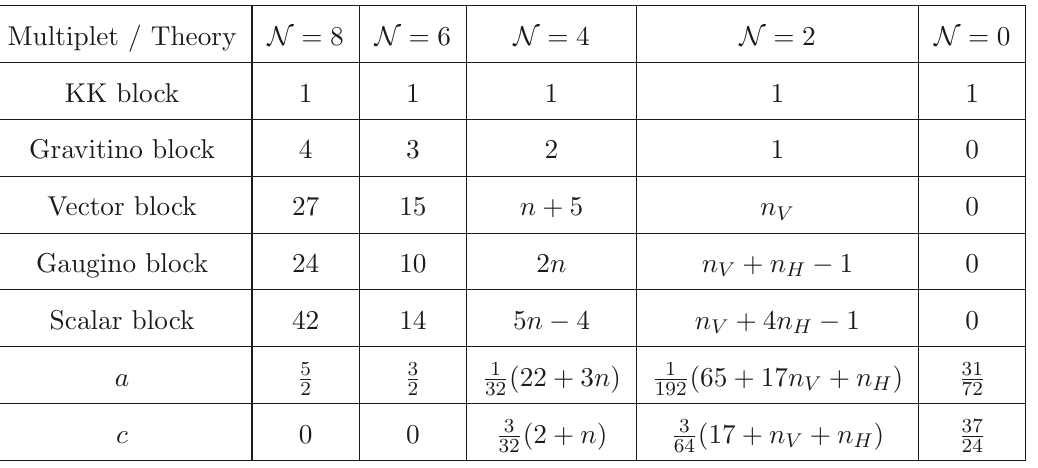
Table 8 . The degeneracy of multiplets in the spectrum of quadratic fluctuations around the KK black hole embedded in to various theories, and their respective values of the c and a coefficients defined in (7.13). For = 4, the integer n is the number of N the recorded values of c and a for the gravitino and the gaugino blocks were only established for ST ( n V 1) −